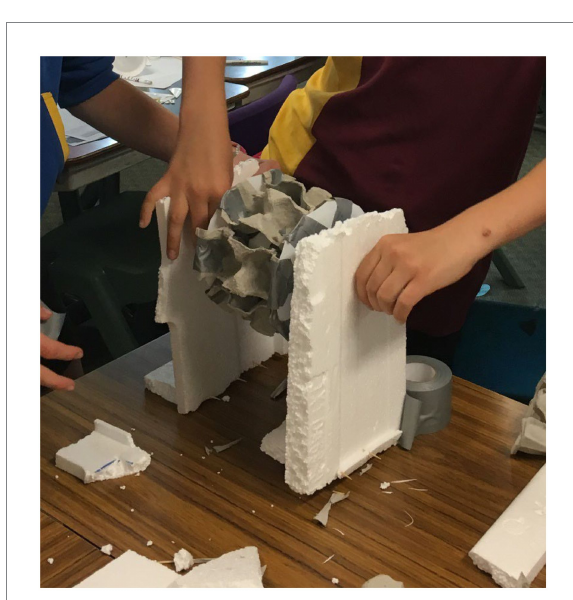
FIGURE 9 Design product for the Non-CoI group showing the use of the egg